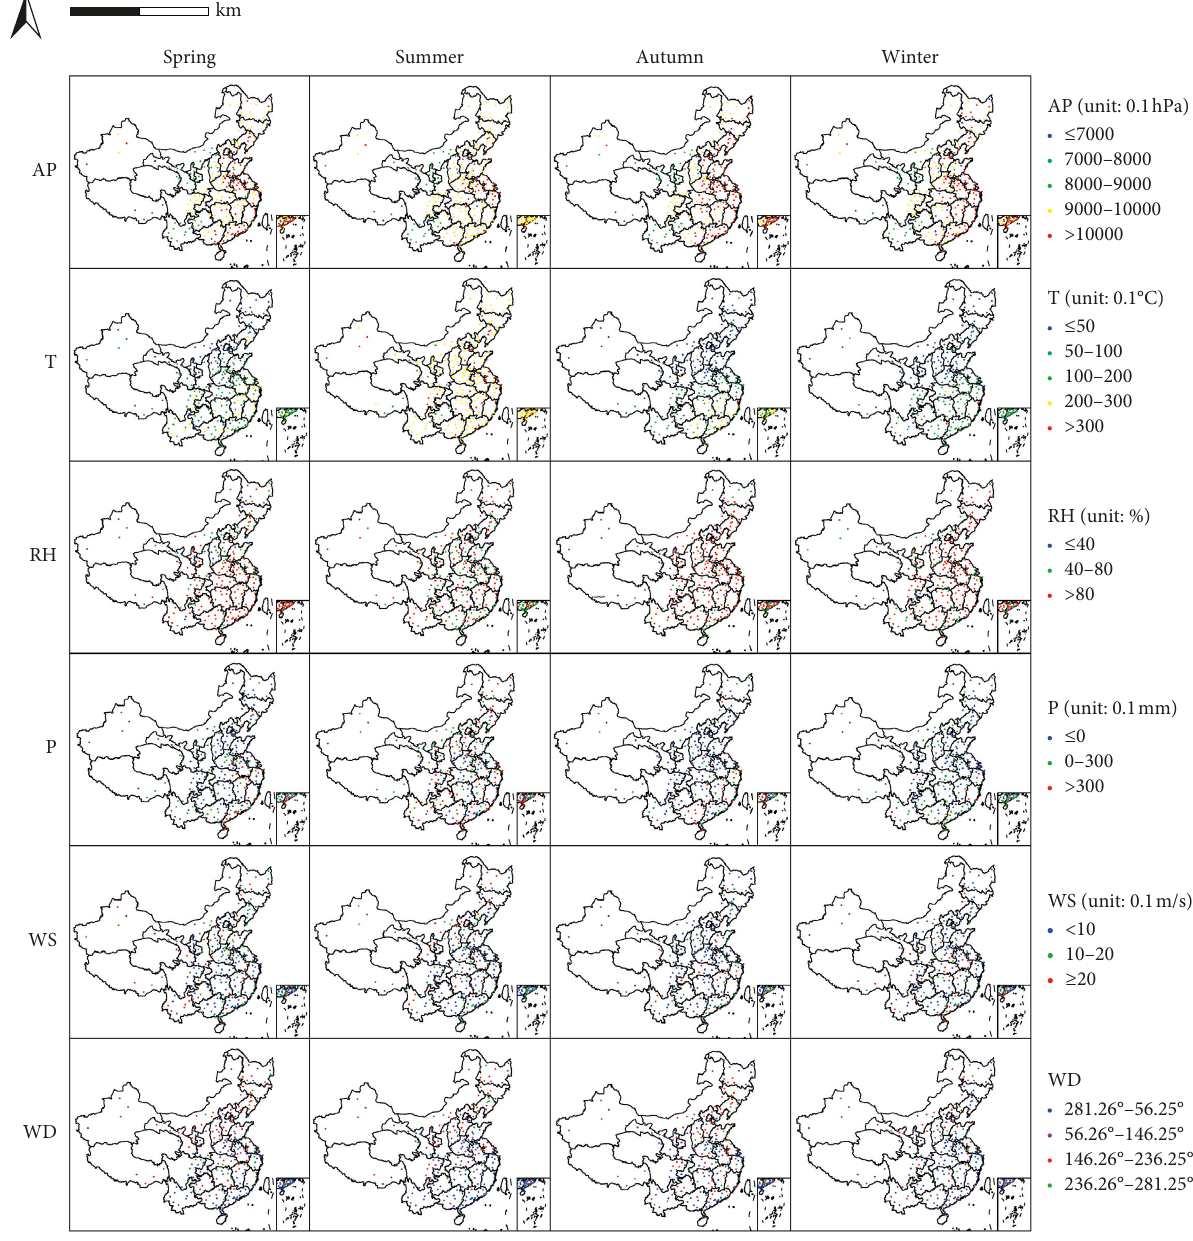
Figure 19: Spatial pattern of the impact of meteorological factors on CO